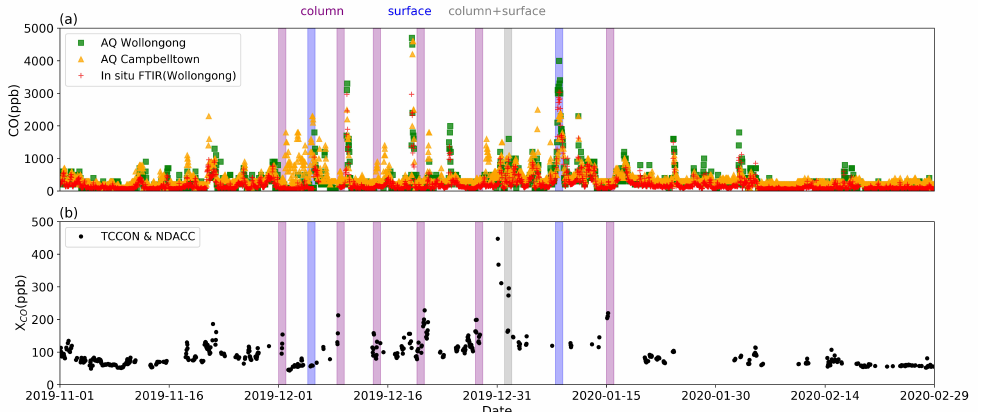
Figure 7. Time series of hourly averaged CO measurements at Wollongong from November 2019– February 2020: ( a ) surface in situ CO measurements at Wollongong air quality monitoring site (green squares), Campbelltown West air quality monitoring site (yellow triangles) and Wollongong in situ FTIR (red crosses); ( b ) column CO measurements (TCCON and NDACC) (black dots). The colour coded vertical bars show the different categories of events: CO enhancements in the column only (purple), CO enhancements in the surface in situ only (blue) and CO enhancements in both column & surface in situ